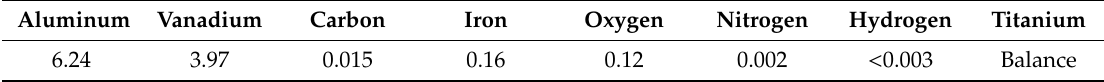
Table 1. Measured chemical composition of the Ti-6Al-4V ELI alloy under study.